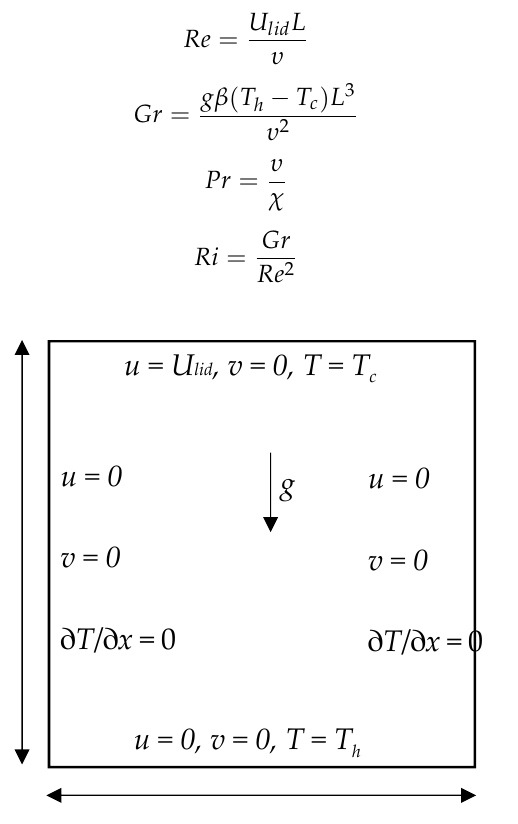
Figure 4. Physical configuration of mixed convection in a lid ‐ driven cavity.